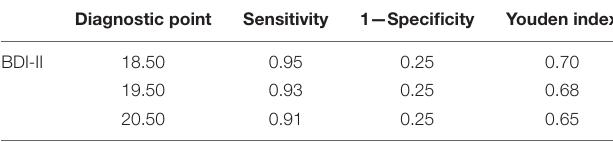
TABLE 6 | ROC curve coordinate point of PIT-P (part).